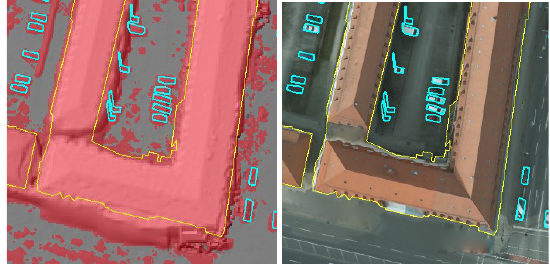
Figure 11. Resulting elevated mask in comparison to the reference data. In both pictures, the contours show buildings and vehicles as provided by the ground truth data. The left image shows a hillshade of the original DSM with the elevated mask in red. The right image shows the corresponding